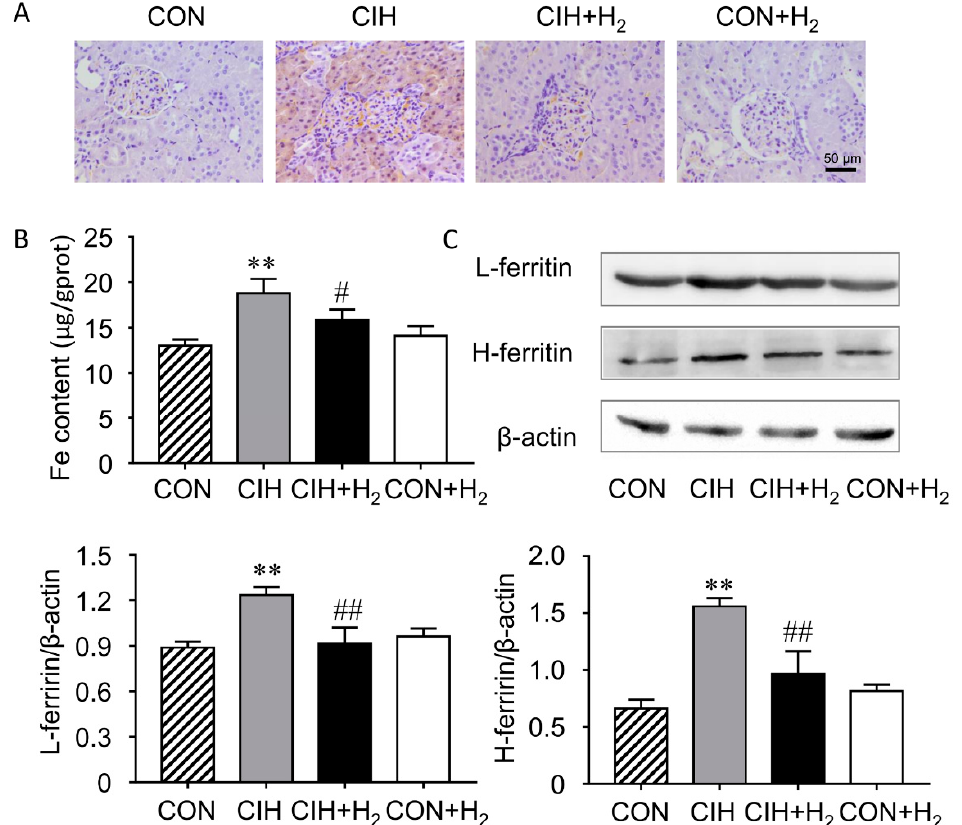
Figure 3. Effect of H 2 on CIH-induced renal iron overload. ( A ). Representative images of DAB (3,3 (cid:48) -diaminobenzidine) enhanced Perl’s Prussian blue staining. Iron is shown to deposit in proximal tubule epithelial cells. ( B ). The contents of renal non-heme iron were determined by colorimetry. ( C ). Western blot showing that H 2 inhibited the increase of both FtL and FtH expression. ** p < 0.01 vs. normoxia group; # p < 0.05, ## p < 0.01 vs. CIH group.